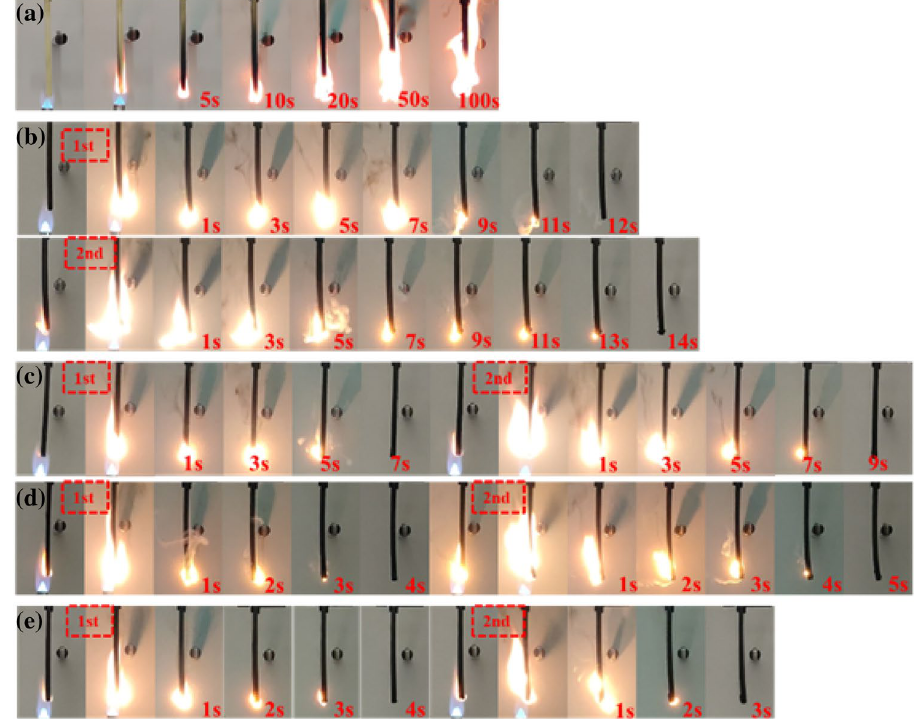
Figure 4. Digital photographs of epoxy thermosets during UL-94 testing. ( a EP, b 5DOPO-CuPc/EP, c 10DOPO-CuPc/EP, d 15DOPO-CuPc/EP, e